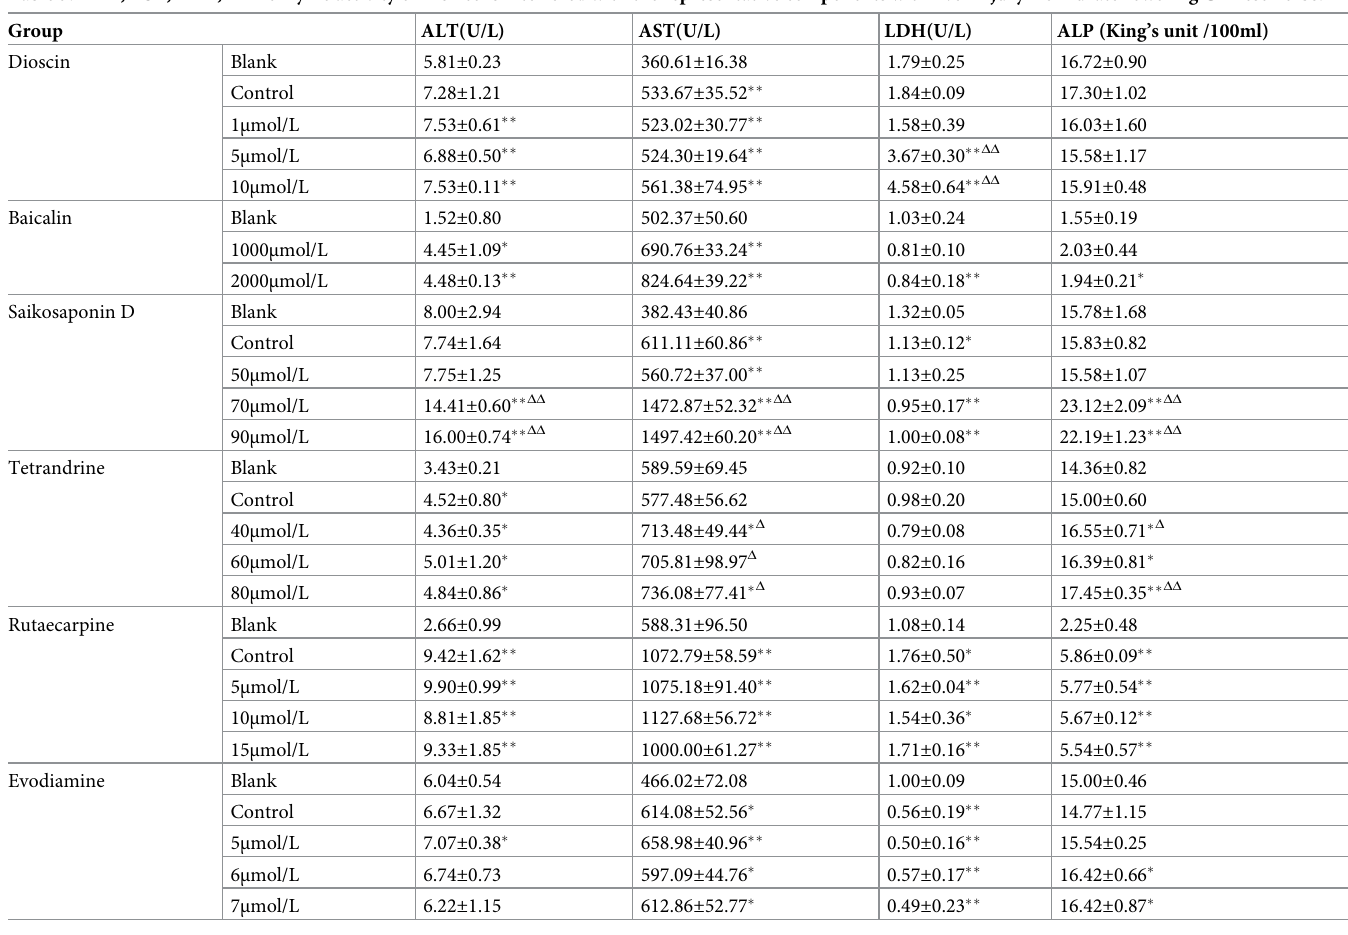
Table 5. ALT, AST, LDH, ALP enzyme activity of L-02 cells interfered with the representative components with liver injury from urate-lowering Chinese herbs. Group